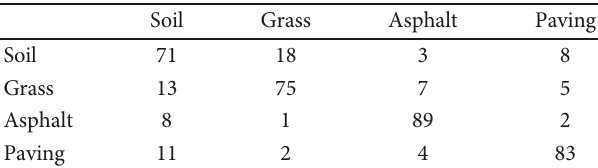
Table 1: Confusion matrix of 10-fold cross-validation with all terrains.